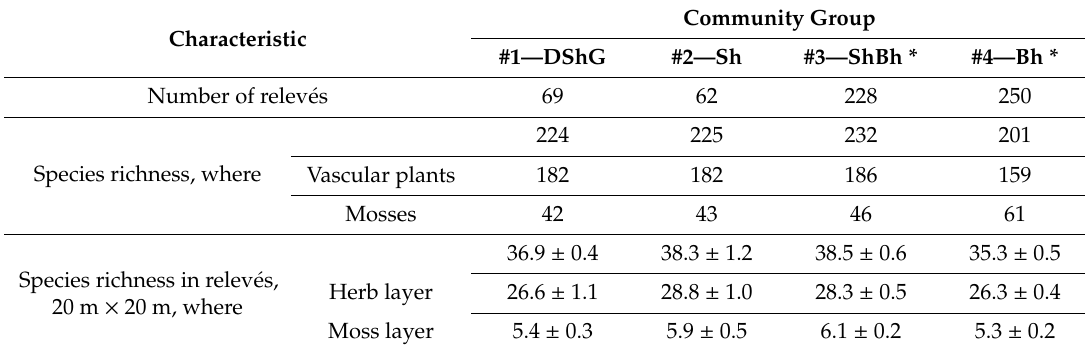
Table A4. Species diversity of ground layer vegetation of spruce and spruce–aspen / birch forests.